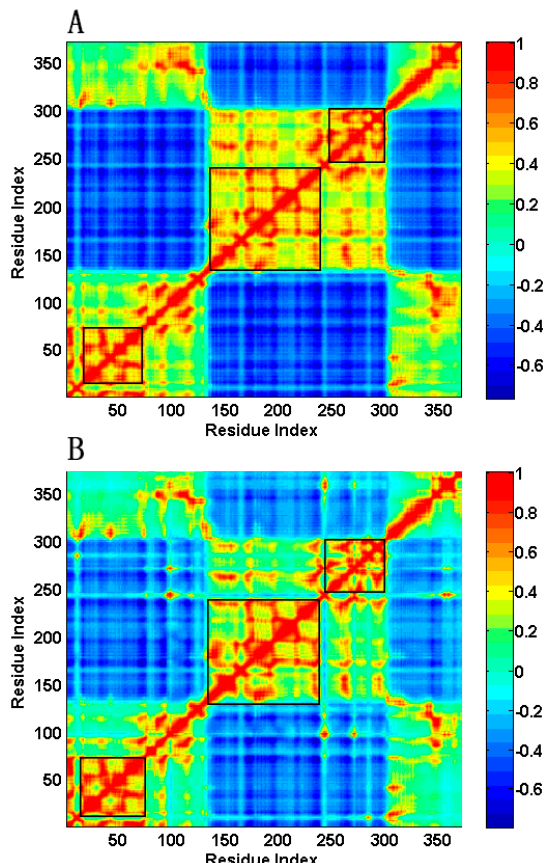
Figure 6. The cross-correlation maps calculated by the first 30 slowest modes of GNM for the open-apo ( A ) and the closed-holo ( B ) structures of L - Mt AlaDH. In this figure, blue regions indicate negative correlation and orange-red regions indicate positive correlation, as shown in the color bar on the right. The regions in the rectangle (Residues 16–74, 134–241, 243–300) indicate the highly coupled regions.